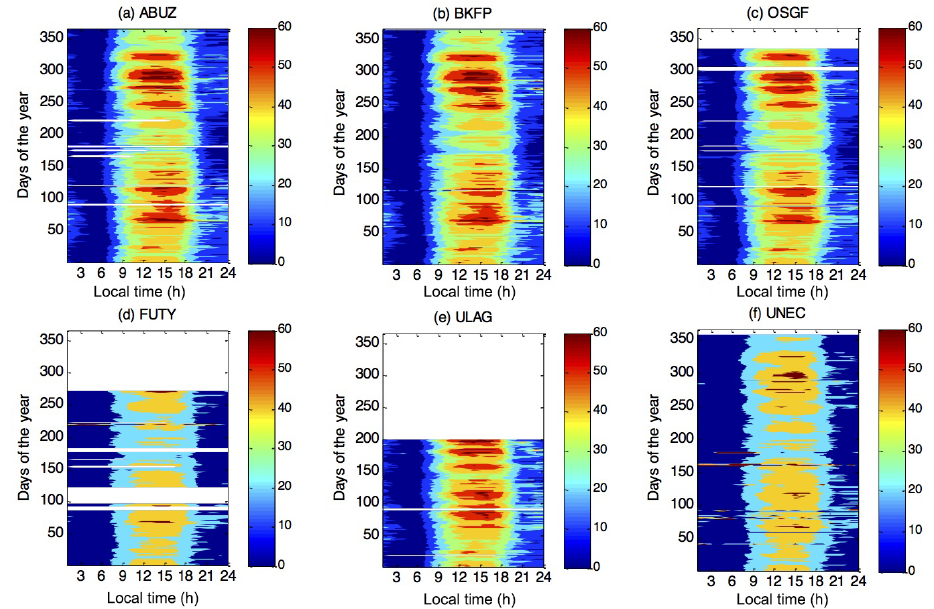
Figure 2. Contour plots of the diurnal variation in GPS TEC measured at the study areas in Nigeria. The white sections in the plots show unavailability of